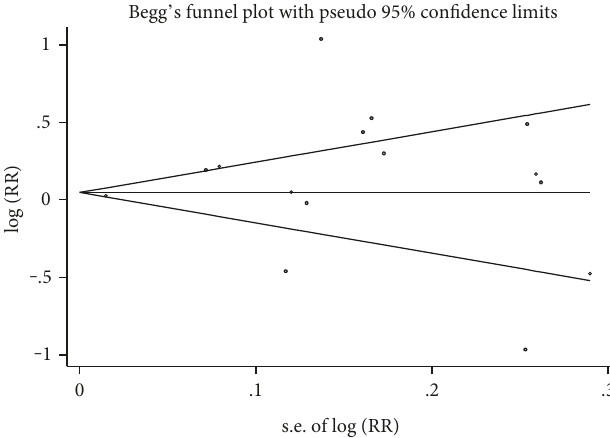
Figure 5: Funnel plot for studies of the association between adiposity and